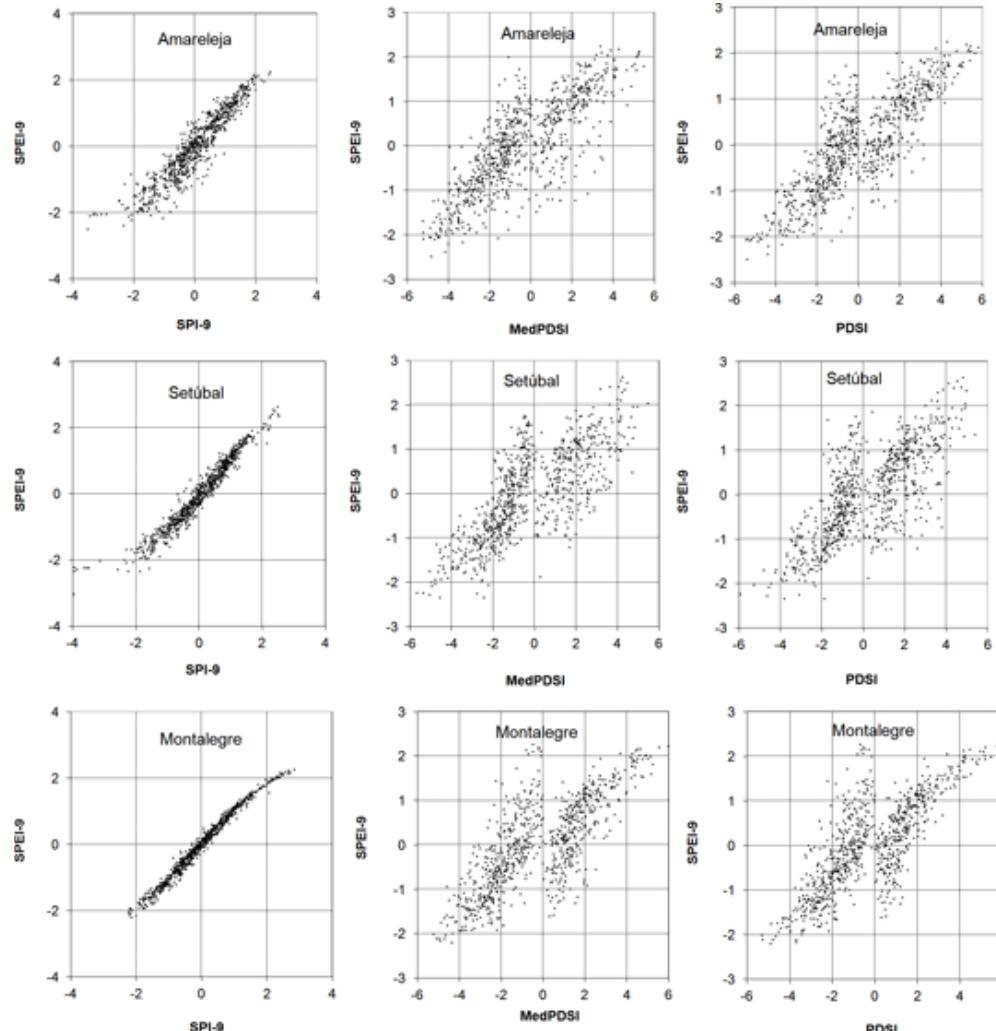
Fig. 2. Scatterplots of SPI-9, MEDPDSI and PDSI vs. SPEI-9month in Amareleja, Set´ubal and Montalegre computed for the period 1941–